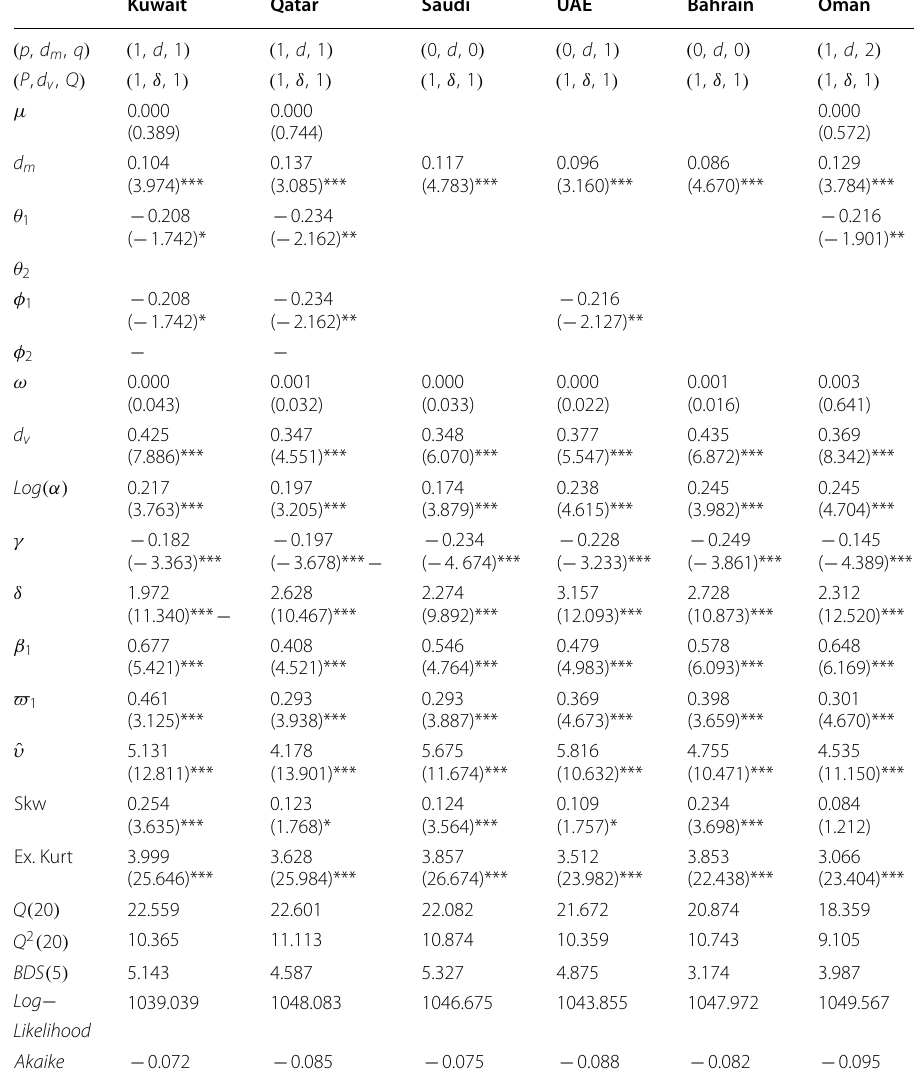
Table 2 Estimates of ARFIMA-HYAPARCH model for each